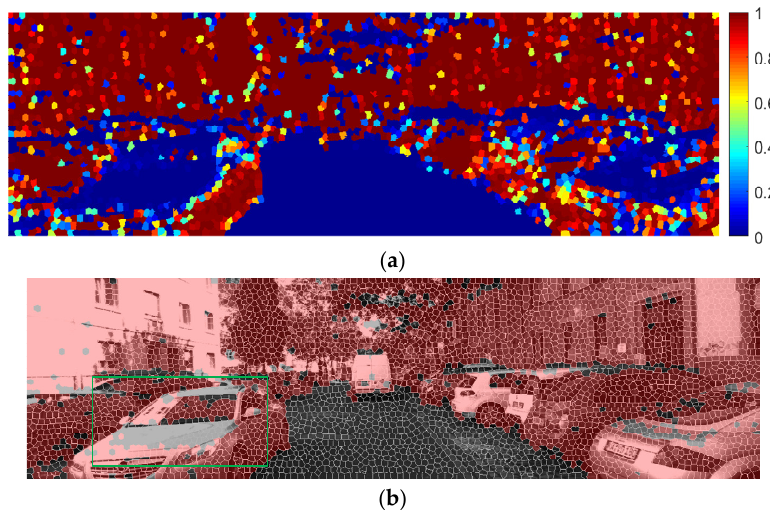
PR and the classification result of the OD-PNV PNV